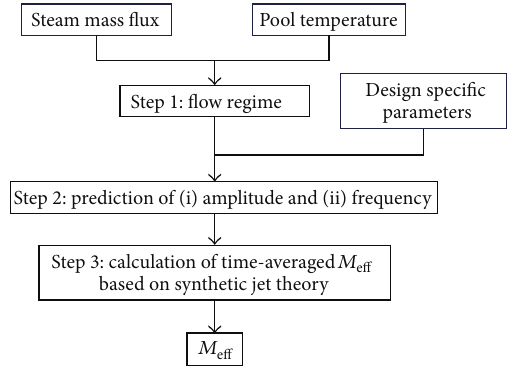
Figure 9: Calculation diagram for the effective momentum 𝑀 with input of steam mass flux, pool temperature, and design specific